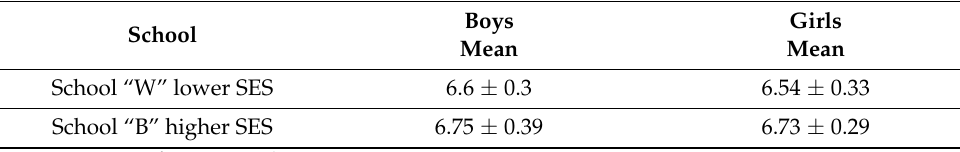
Table 2. Descriptive Age—School “W”—lower SES and School “B”—higher